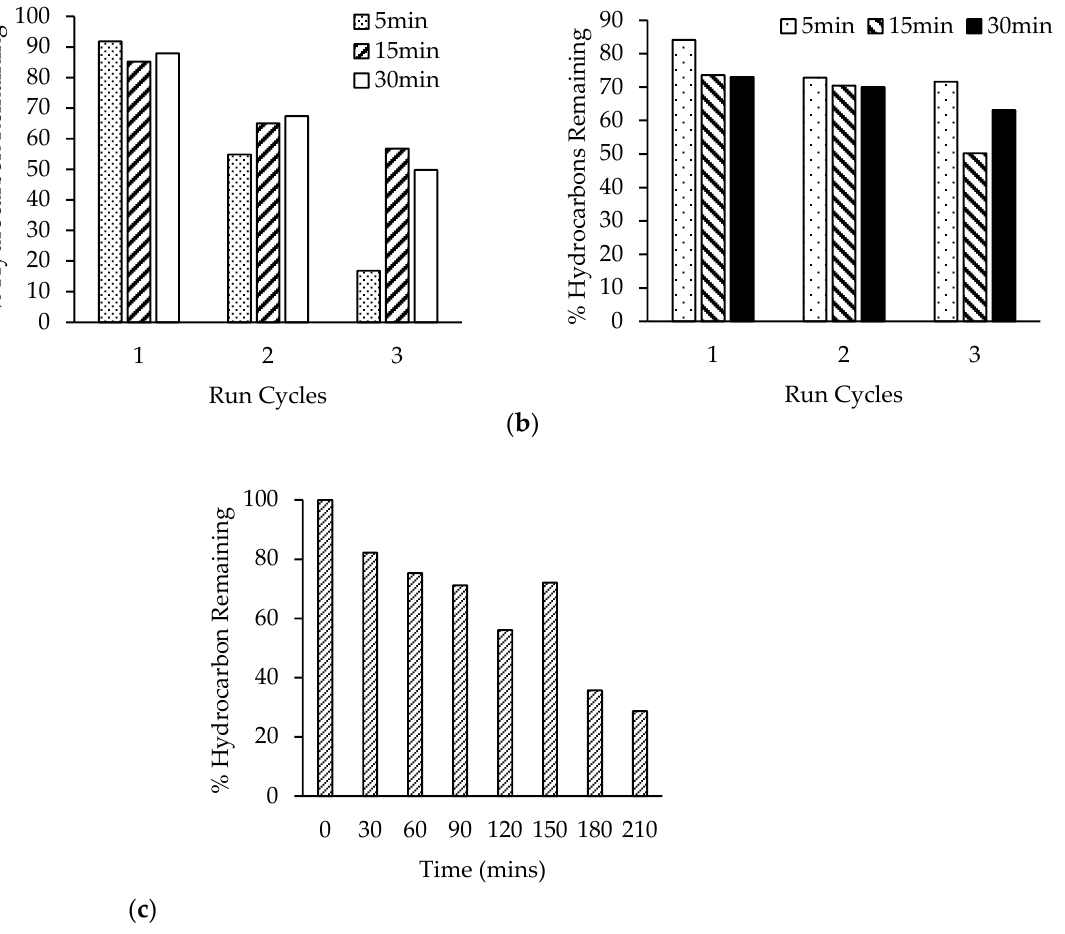
Figure 7. Percentage of hydrocarbons remaining in the consolidated particles after ( a ) WAO, ( b ) WAPO, and ( c ) WAO extended.